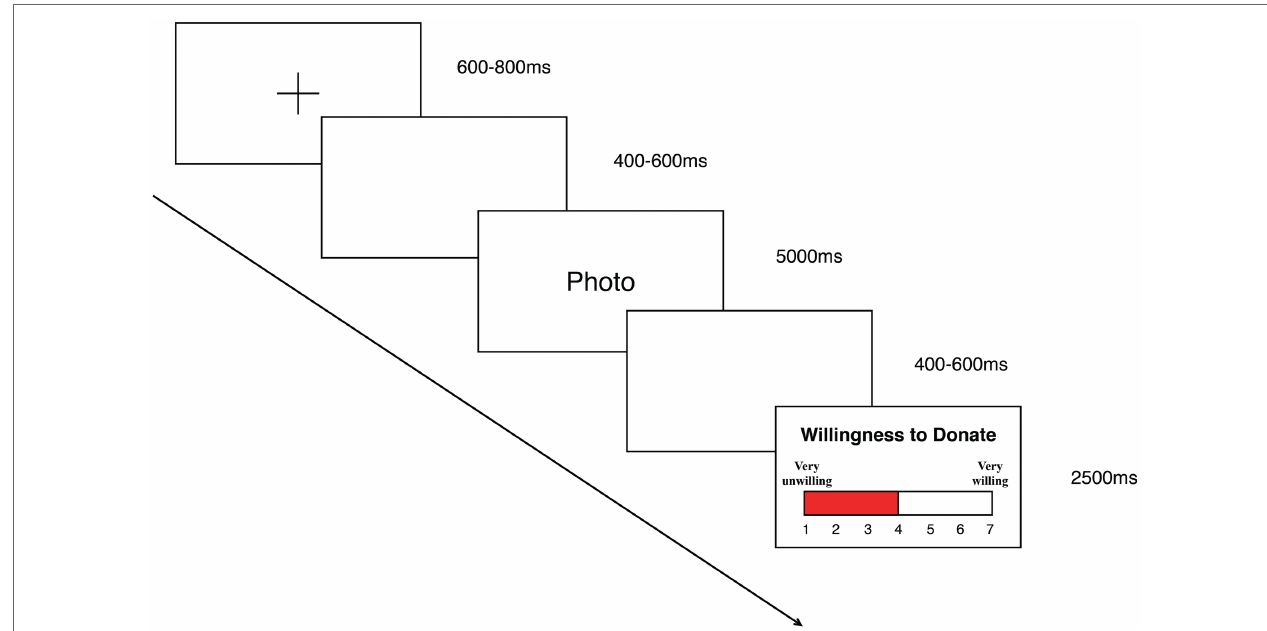
FIGURE 2 | Single trial of the experimental procedure. Participants are instructed to report their donation intention under the condition that the number of donated peers was large or small. EEGs and behavioral data were recorded throughout the experiment.